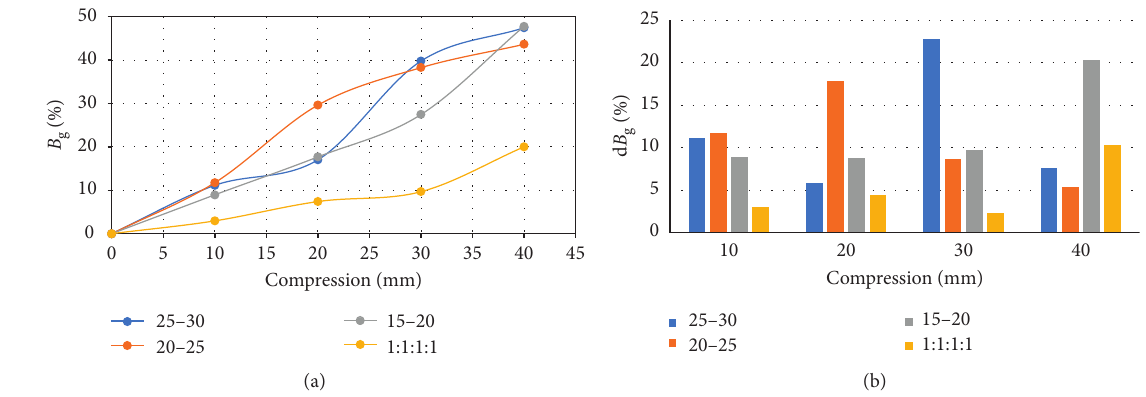
Figure 8: The relationship between particle breakage and compaction